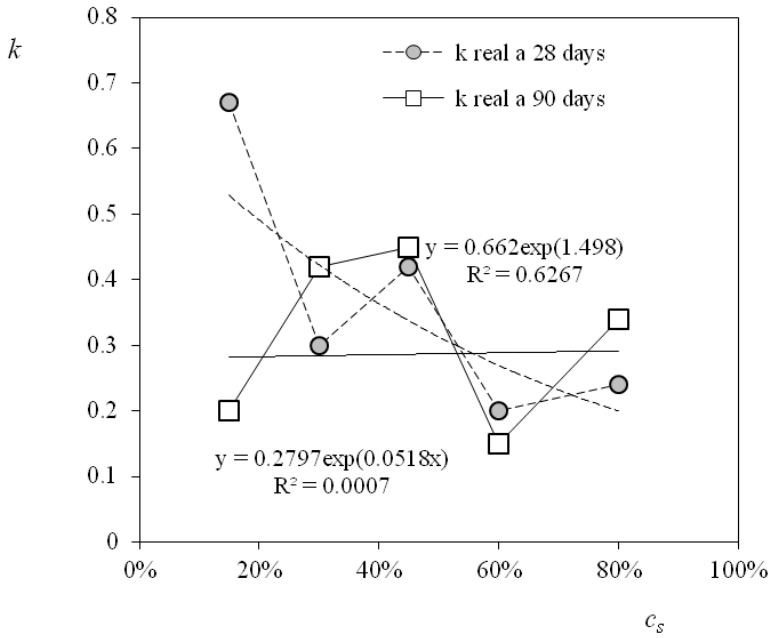
Figure 10. Evolution of the value of ‘ k real’ depending on the amount of glass powder contained in the binder ( Gp ).